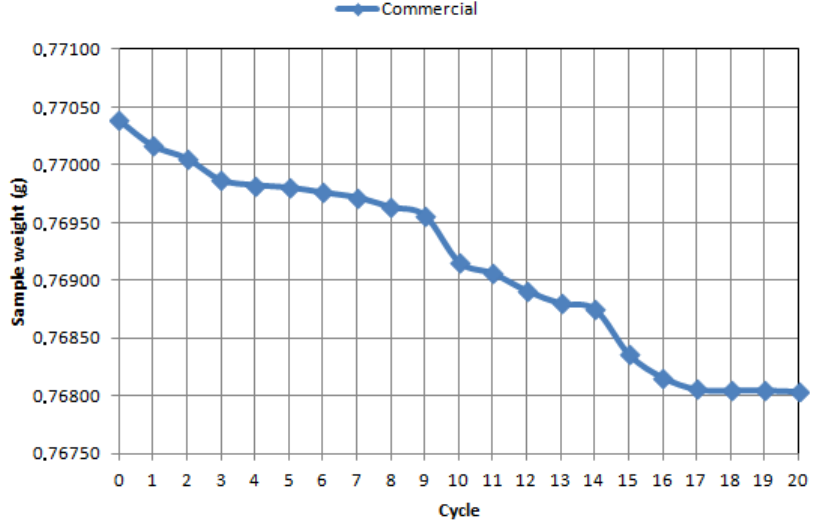
Figure 9. Loss of mass during tribological testing after 20 cycles for a commercial WCCo sintered cutting insert at 5 N.